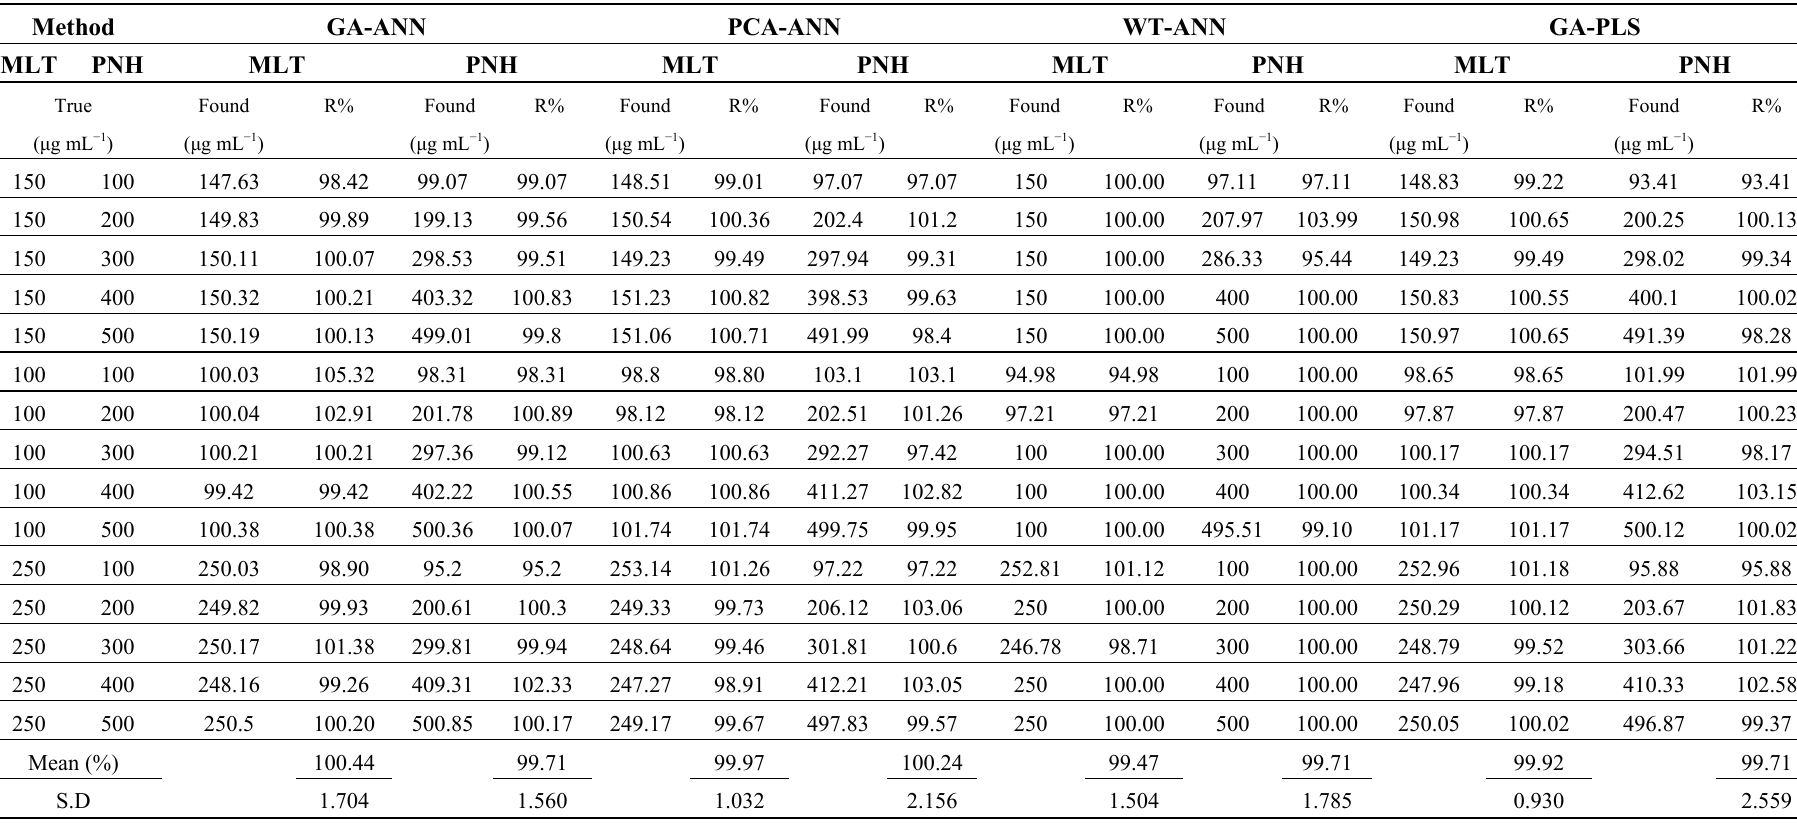
Table 6. Analysis results for the prediction of MLT and PNH in the training set by the proposed multivariate calibration